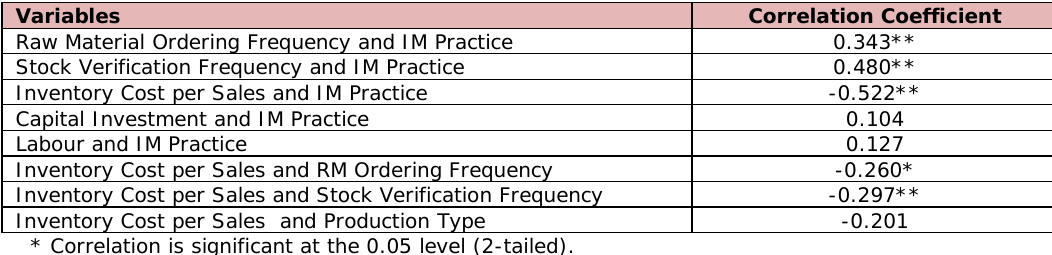
Table 6. “Rank Correlation between